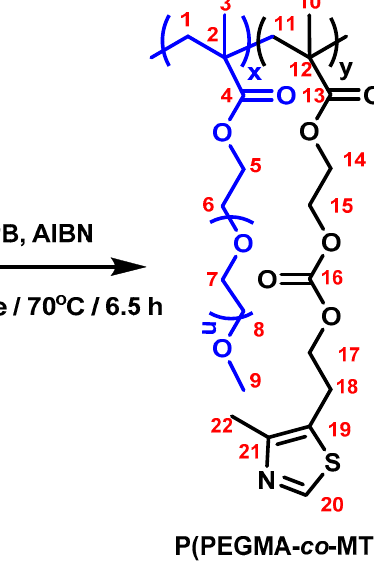
Scheme 1. Reversible addition-fragmentation chain transfer (RAFT) copolymerization reaction